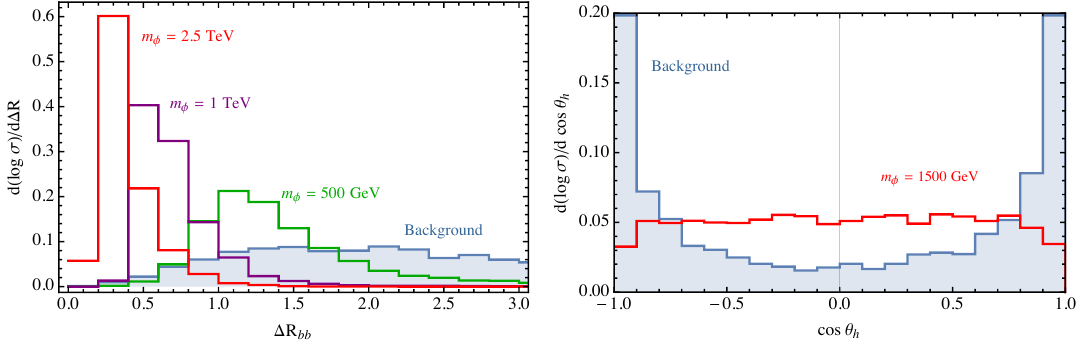
Figure 13. Left: distribution in (cid:1) R bb of the background and the signal (for m (cid:30) = 500 GeV, 1 TeV, and 2.5 TeV) at the 3 TeV CLIC. Right: distribution in cos (cid:18) h for both signal ( m (cid:30) = 1 TeV) and background at 3